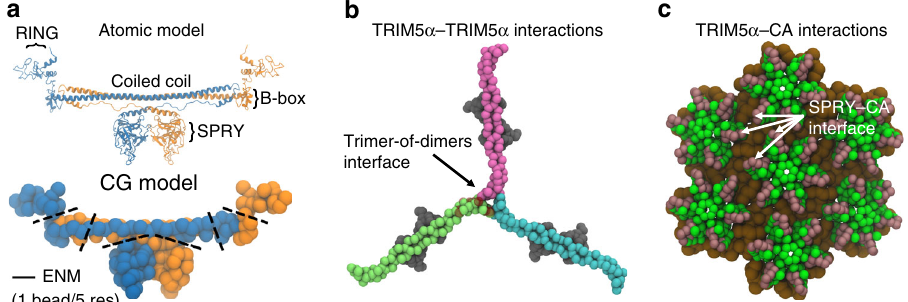
Fig. 1 Minimal interactions for capsid-induced TRIM5 α self-assembly. a Atomic and CG representations of the TRIM5 α dimer. Each monomer subunit is colored in orange and blue, respectively. Labels indicate distinct structural domains (Top). Dashed lines highlight locations of elastic network models used to confer fl exibility to the dimer in the CG model (Bottom). b A snapshot of a higher-ordered TRIM5 α trimer-of-dimers structure assembled during our simulations. Dark red spheres depict the locations of virtual sites for the central TRIM5 α dimer (pink), which act as tethering sites for the adjacent TRIM5 α dimer (lime). c CG representation of the capsid surface. The N-terminal domain is colored in green, whereas the C-terminal region is colored in brown. Dark pink spheres re fl ect sites of attractive interactions with the SPRY